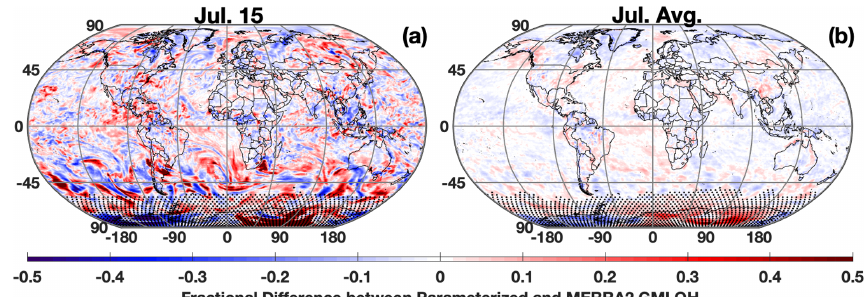
Figure 1. Fractional difference between the parameterized and MERRA2 GMI OH averaged over the LFT (top of the PBL to 500hPa) for 15 July 2005 (a) and averaged across all days for July 2005 (b) . Regions with low OH, defined as a mixing ratio of less than 0.005pptv, are indicated with stippling.